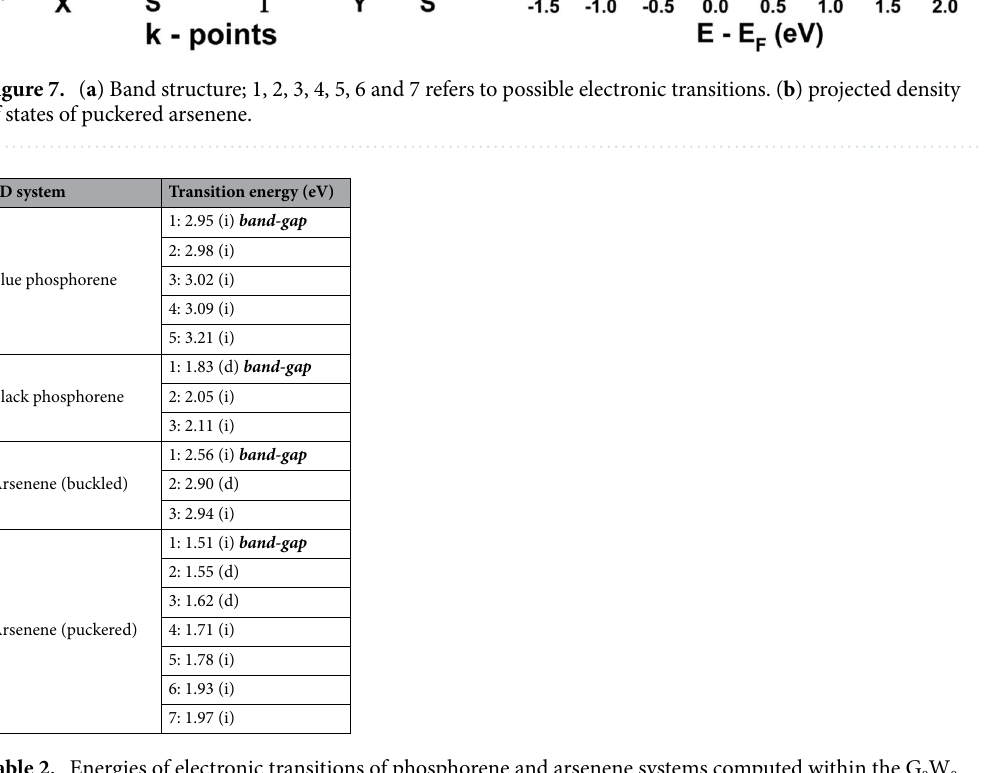
Table 2. Energies of electronic transitions of phosphorene and arsenene systems computed within the G 0 W 0 approach, (i) and (d) denote indirect and direct transitions respectively. From Table 2, we can conclude that our findings agree with previous results for monolayers and heterostructures based on these materials 65–67 . Significant values are in